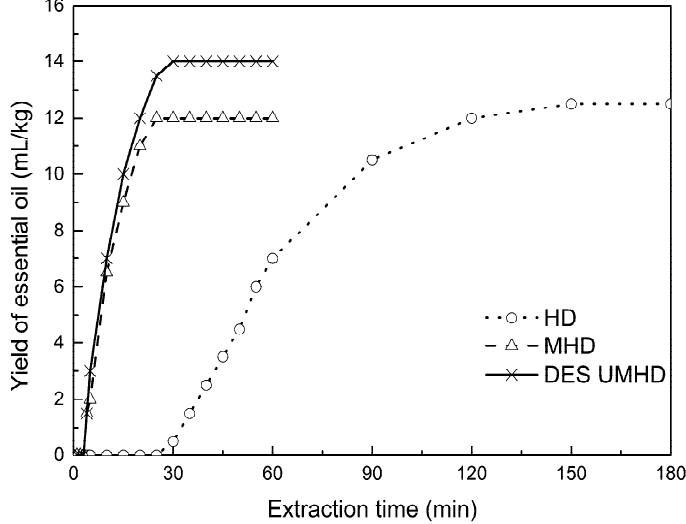
Figure 11. Kinetic study of essential oil extraction.